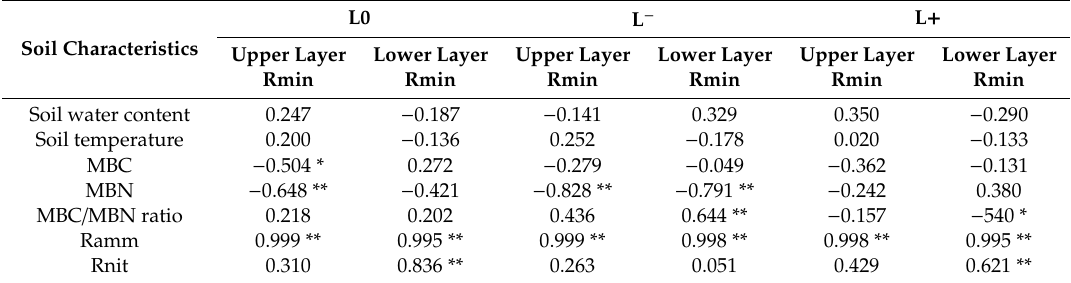
Figure 6. Monthly dynamics of the contents of soil net N mineralization of different litter manipulation in varied soil layers of the Larix gmelinii forest. Different capital letters indicate significant differences between manipulations in each soil layer, and different lowercase letters indicate significant differences among different months ( p < 0.05) ( n = 9).